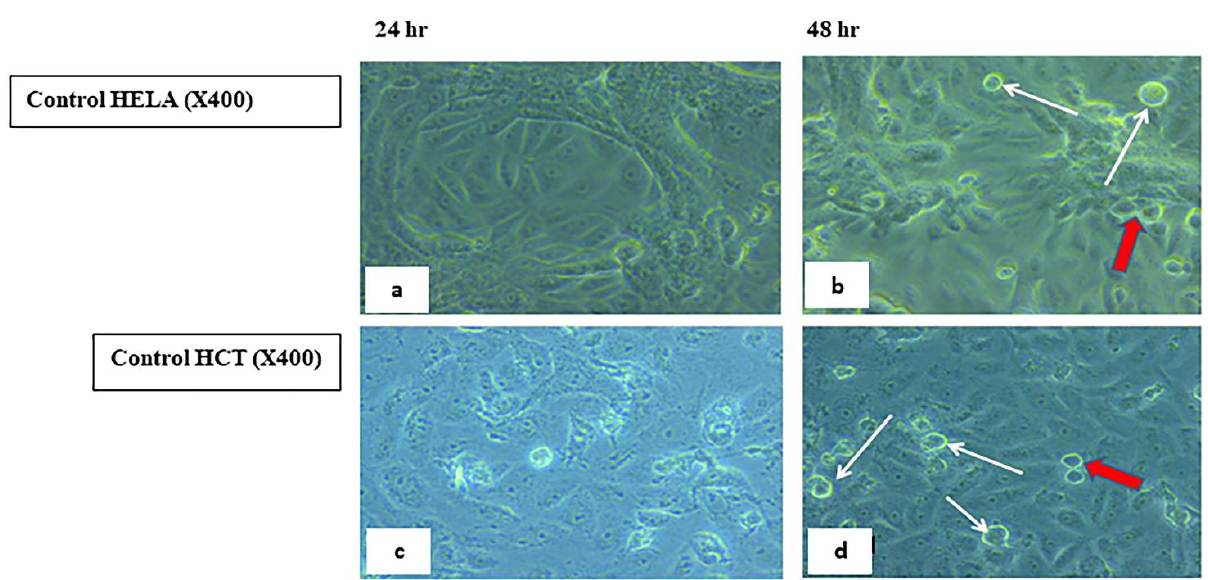
Figure 8. Control (untreated) human HELA and HCT cell lines. Panels ( a , c ) show 90% confluent, spindle shaped adherent cells 24 h after culturing. Panels ( b , d ) show confluent spindle shaped adherent cells, 48 h post-culture. (Phase contrast, X100).